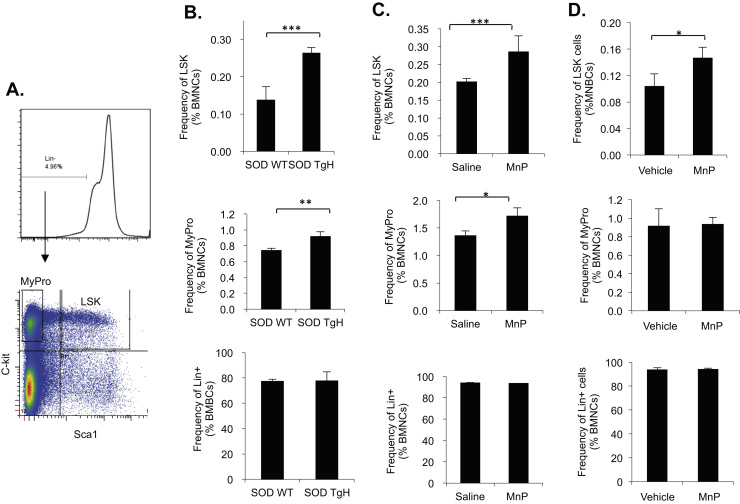
LSK & MyPro cell frequency is increased in MnSOD transgenic mice and the cells treated with MnP in vitro and in vivo. A. The gating strategy of flow cytometry analysis. B. Bone marrow cells were isolated from wild- type (SOD WT) or MnSOD transgenic (SODTgH) mice. C. C57B/L6 mice (n=8) were injected (i.c.) with vehicle (Saline) or MnP (MnP) at 2 mg/kg, 3 times/week for 60 days. D. Freshly isolated bone marrow cells from C57B/L6 mice (n>6) were treated with vehicle (H2O) or 20 μM MnP (MnP) for 16 h in vitro. Cells were immunostained and flow cytometry analyzed. Upper panels are the percentage of LSK cells (lin- Sca1+ c-kit+) in the total bone marrow nucleated cells (BMNCs). The middle and lower panels are MyPro (lin- Sca1- c-kit+) and lineage positive (Lin+) cells, respectively. *P<0.05 was considered significant (Student's t-test). *P<0.05; **P<0.01; ***P<0.001 as compared with controls for this and the following figures. Data represent the mean+SD of at least three independent experiments.